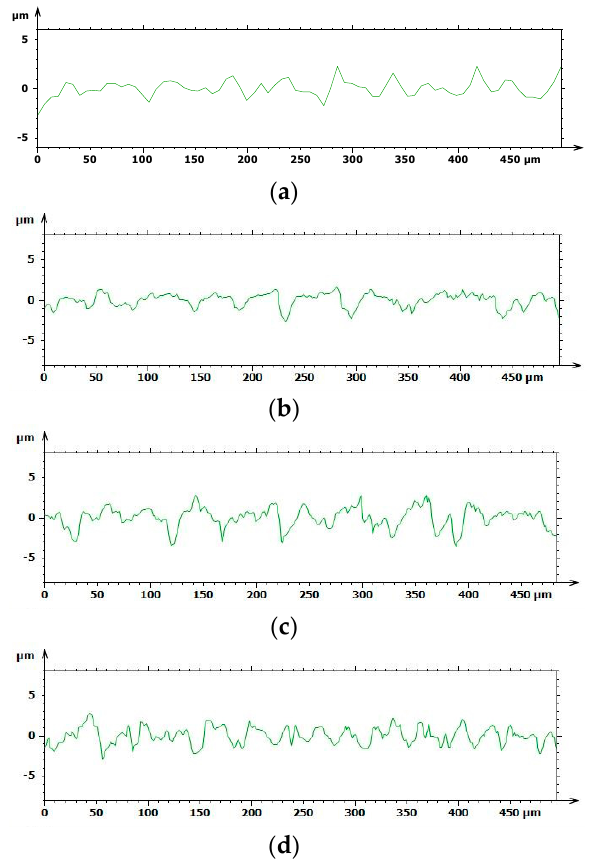
Figure 4. Roughness profiles of the implant surfaces extrapolated using Leica Map ( a ) A, ( b ) B, ( c ) C, and ( d ) D.